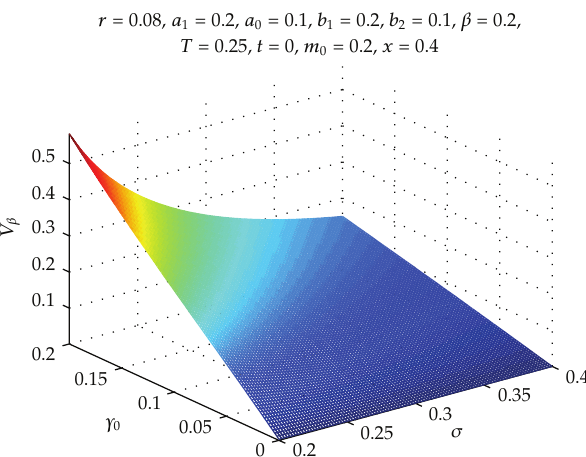
Figure 6: V β as a function of σ and γ 0